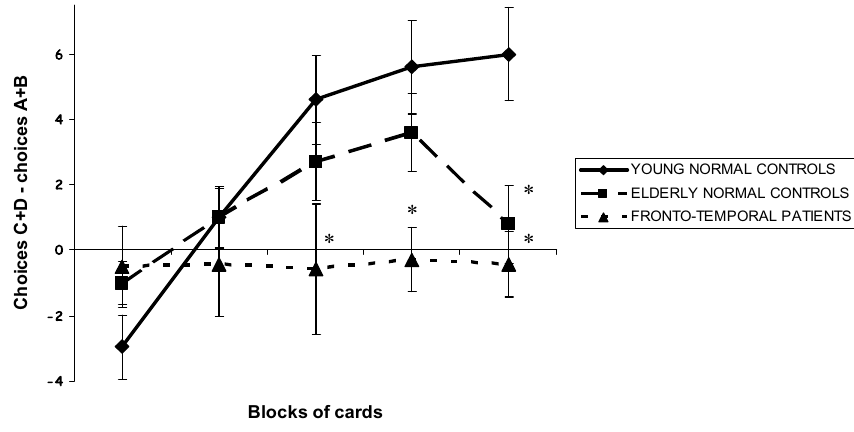
Fig. 1. Performance of the three study groups at the Iowa Gambling Task, with each block including 20 successive cards. The score is represented by the number of choices from advantageous decks (C and D) minus the number of choices from disadvantageous decks (A and B). A negative score indicates poor decision